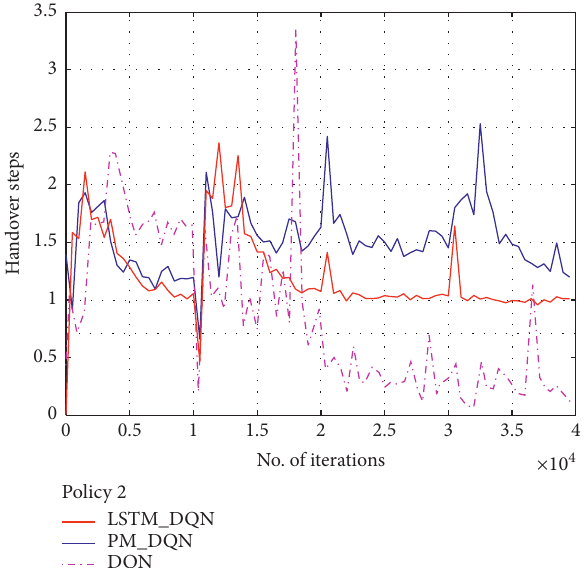
Figure 11: Relationship between the number of iterations and handover steps (policy 2).